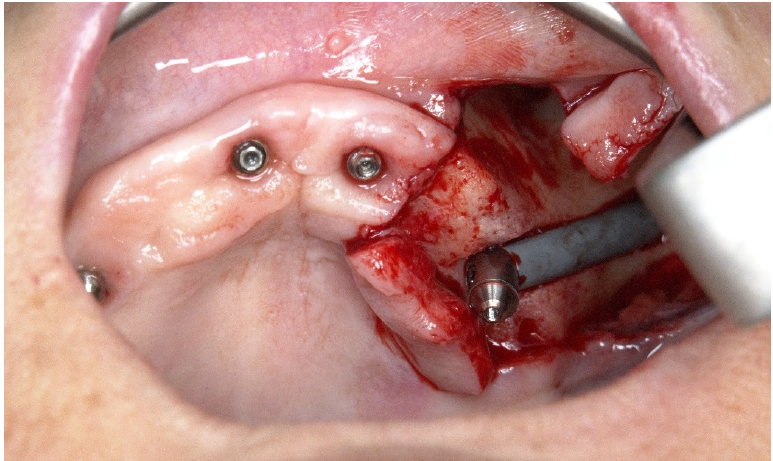
Figure 31. Orthopantomography with the definitive prosthesis connected one year after the intervention. 3. Discussion The predictability of the rehabilitation process described in the present case reports provided the necessary stability to connect an implant-supported fixed prosthesis that enabled comfort, aesthetics, and function to the patient through the implants’ functional osseointegration period. Various advantages arise from the use of guidance methods for implant placement, including the accuracy of implant placement, cost-effectiveness, and less chair-time [9]. A previous review compared the use of dynamic navigation with static guides during implant placement: [5] The main differences between both modalities concern the use of computed tomography-generated data to create computer-aided design (CAD) and computer-aided manufactured (CAM) static guides (stents) used during surgery to place implants in a predetermined position without the possibility of changing the implant position perioperatively, while for the dynamic navigation system, the operator uses a triangulation setup provided by the computer to guide the implant placement. Potential advantages and disadvantages arise from both modalities.